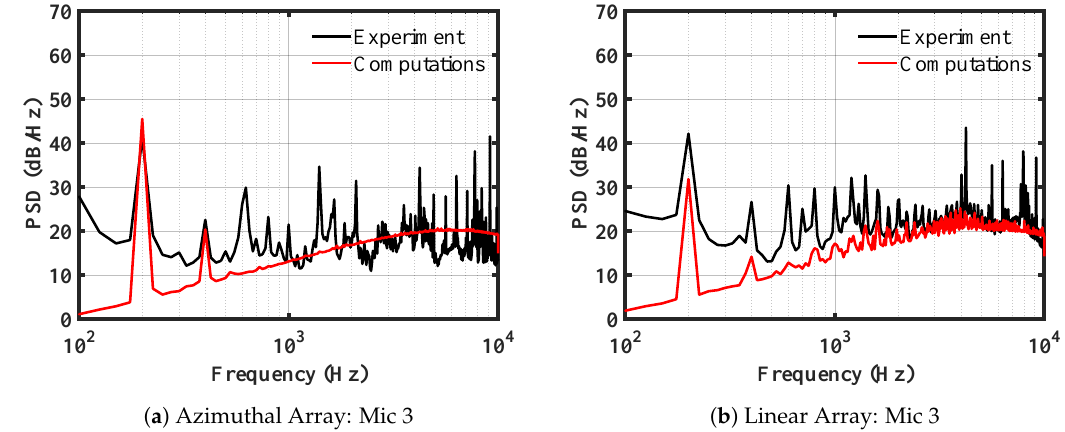
Figure 14. Sound pressure level of the isolated rotor in hover at 6000 RPM measured at two different mic locations.